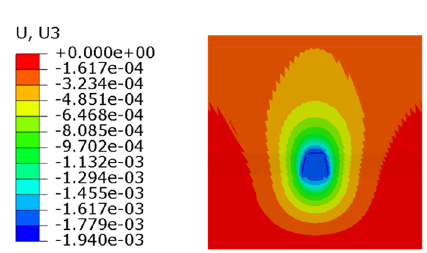
Figure 22. Condition 1 stress cloud diagram.